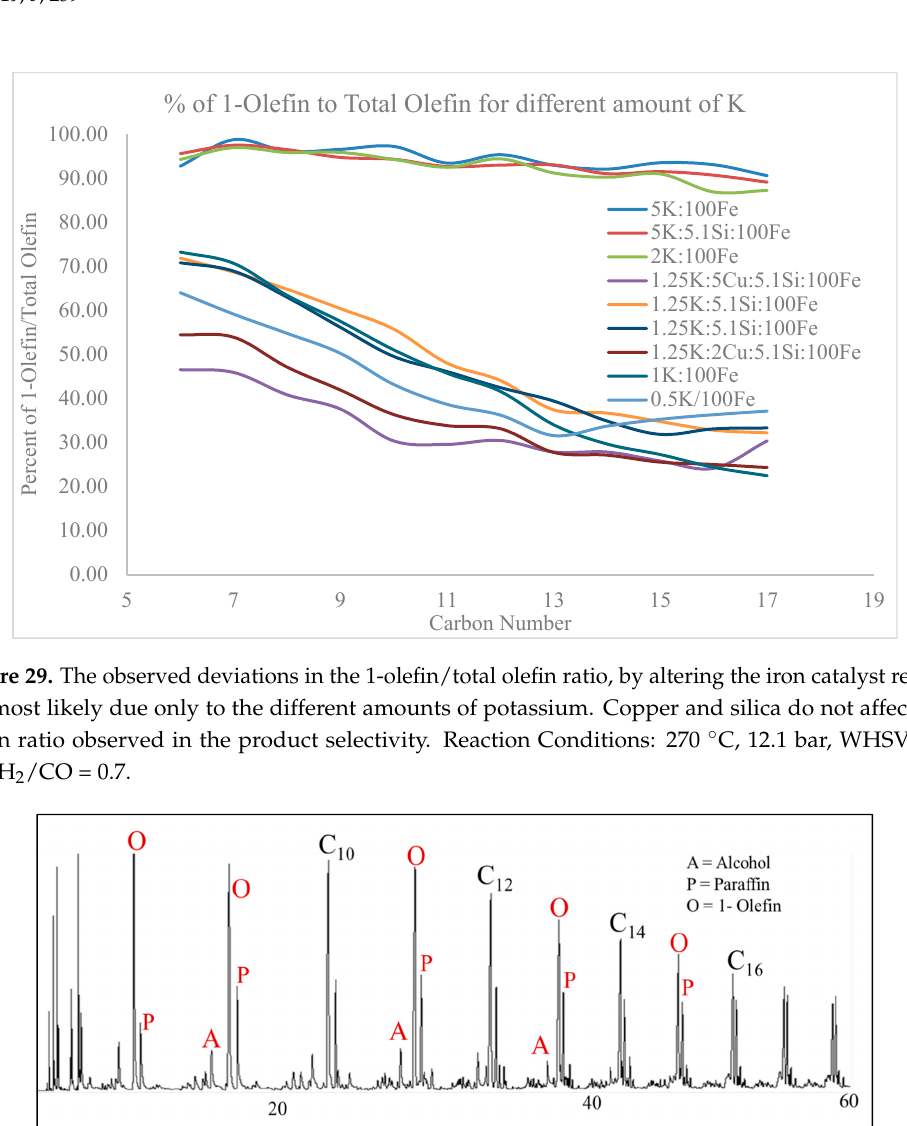
Figure 30. A chromatograph of the product produced with a manganese supported iron catalyst. The x-axis is retention time in minutes. Reaction Conditions: 270 °C, 12.1 bar, WHSV = 2, and H 2 /CO = 0.7.